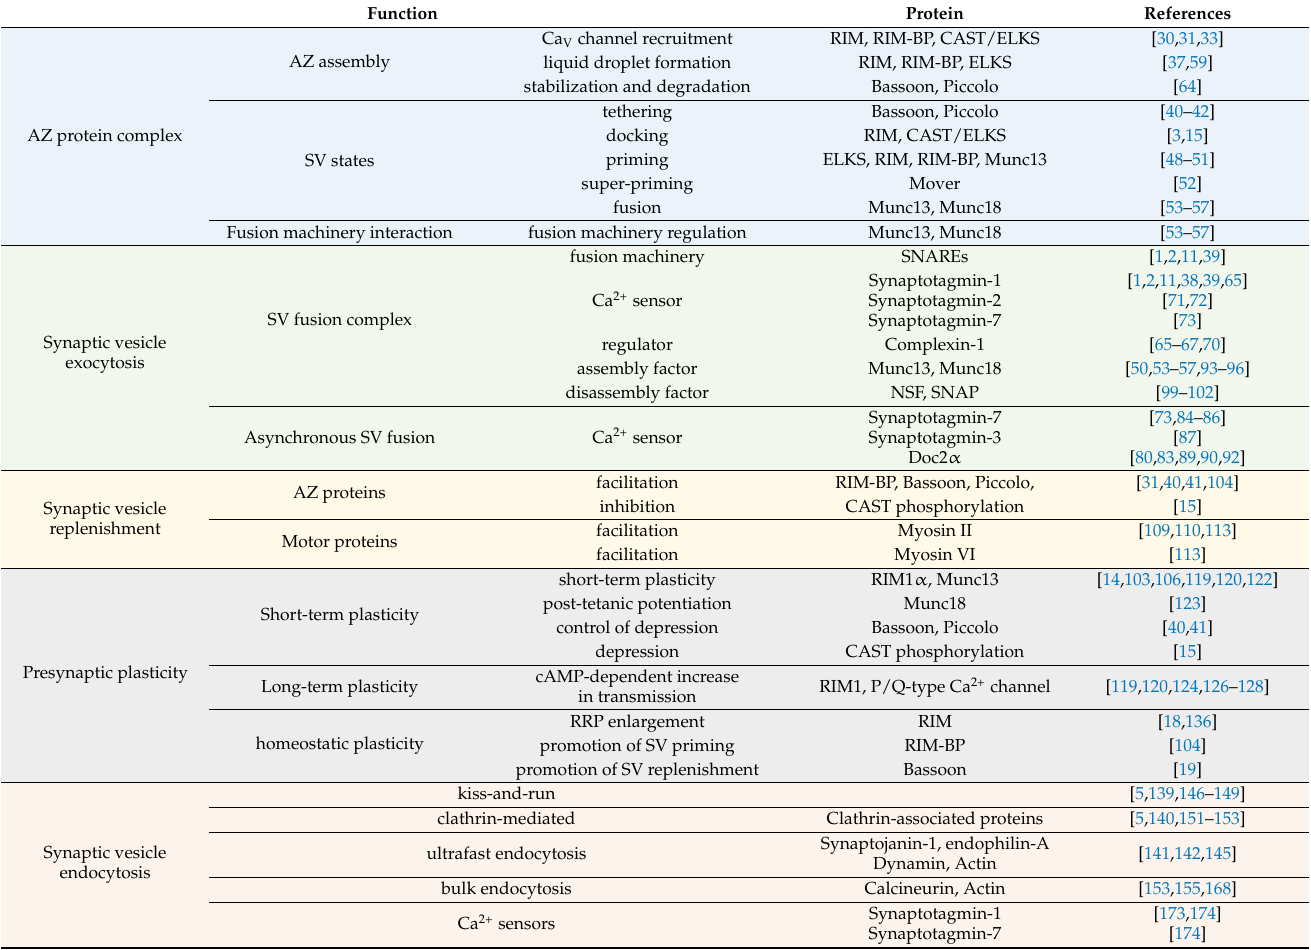
Table 1. Molecular players act in the presynaptic release site active zone, synaptic vesicle exocytosis, replenishment, and